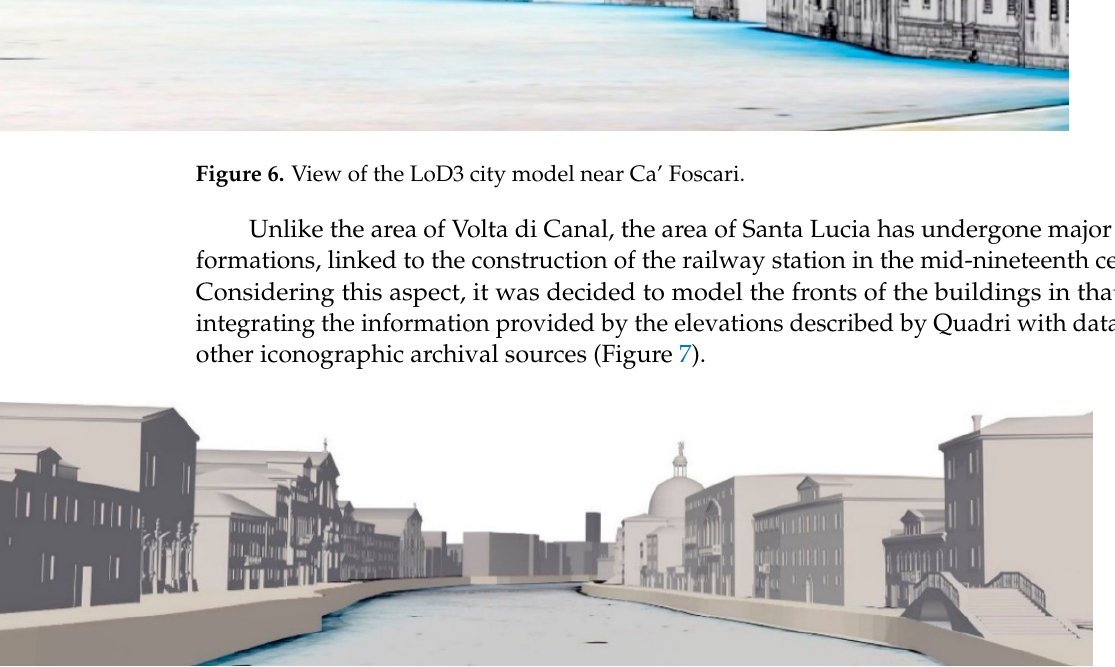
Figure 7. View of the LoD3 city model in the area of Santa Lucia.